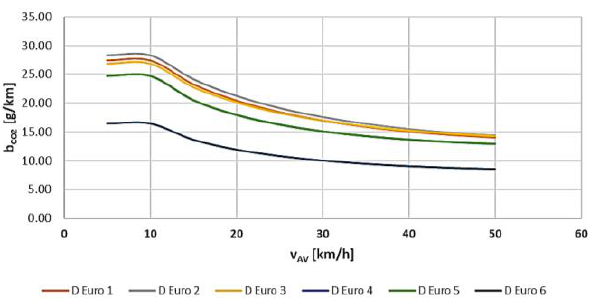
Fig. 7. CO 2 emission from diesel oil PCs for vehicle depending on average speed